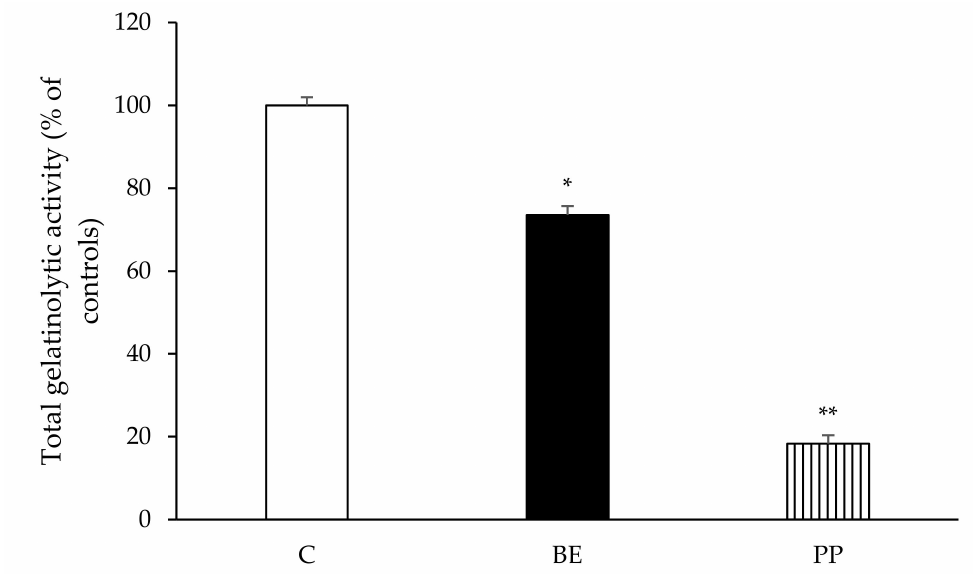
Figure 3. The effect of buffer extraction (BE) and purified protein (PP–deflamin) on the proteolytic activity of MMP-9. Each well was loaded with 50 µ g.mL − 1 of protein and gelatinolytic activity was measured by the DQ-gelatin assay. MMP-9 activity is expressed as relative fluorescence as a % of controls and correspond to the means of at least three replicate assays (n = 3) ± SD. * p < 0.05, ** p <